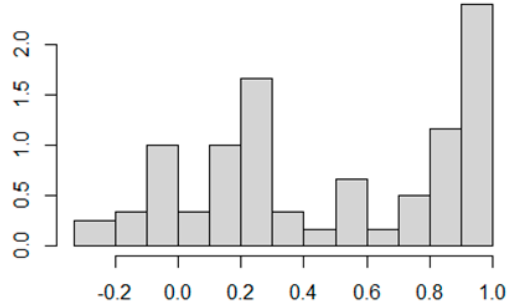
Figure 8. The histogram for rank correlation—2021 based on a statistical computing platform [32].